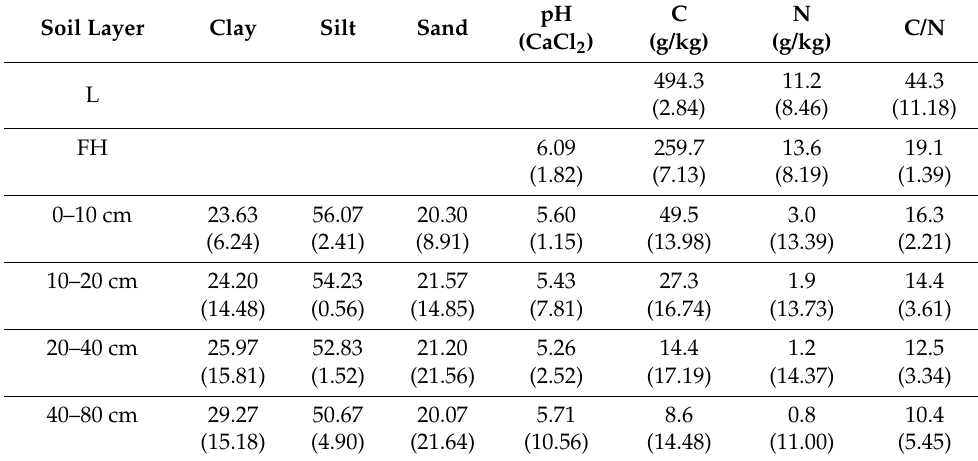
Table 1. Average values of texture fractions (%), pH and concentrations of C and N (g/kg). Values of coefficient of variations (%) are shown inside